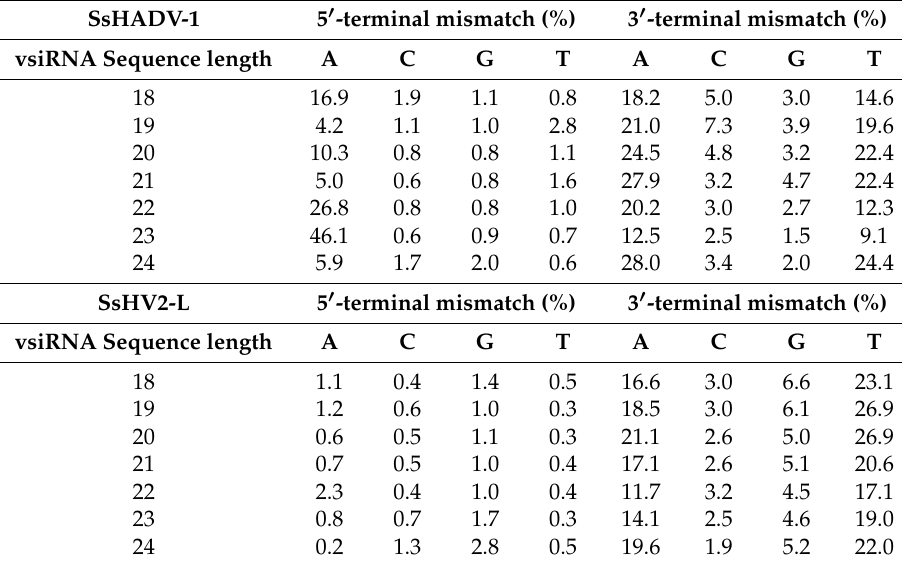
Table 1. Percentage of SsHV2-L and SsHADV-1 derived small RNAs containing mismatches relative to viral genomes. SsHADV-1